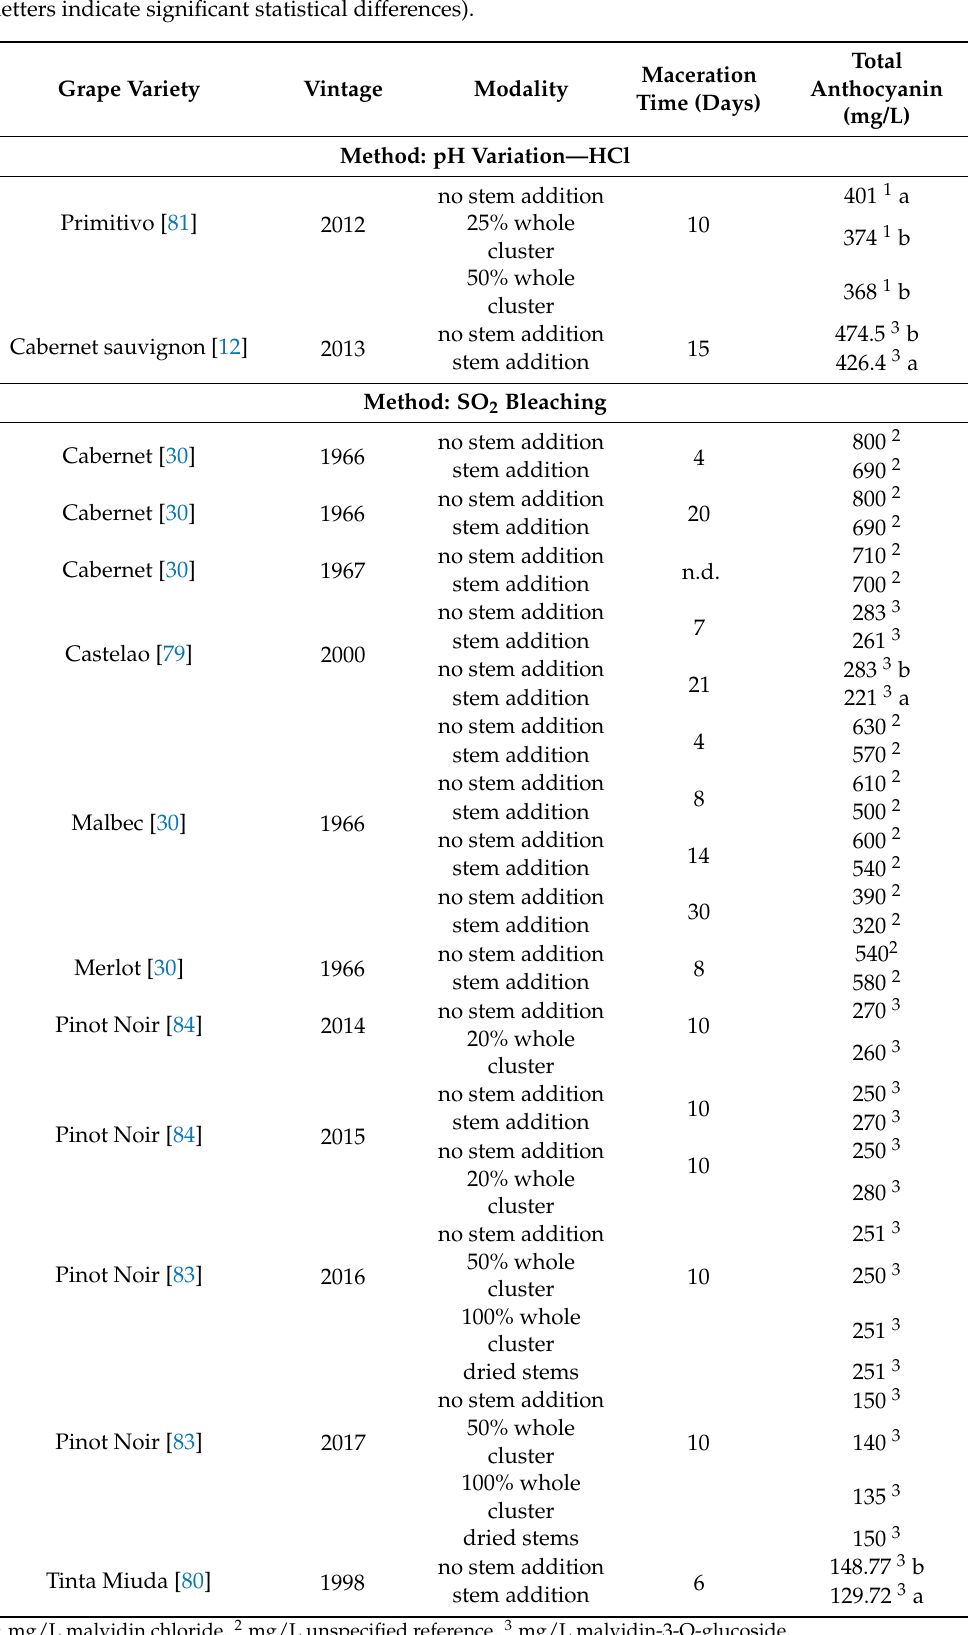
Table 19. Impact of stems during winemaking on total anthocyanin content (for each study, different letters indicate significant statistical